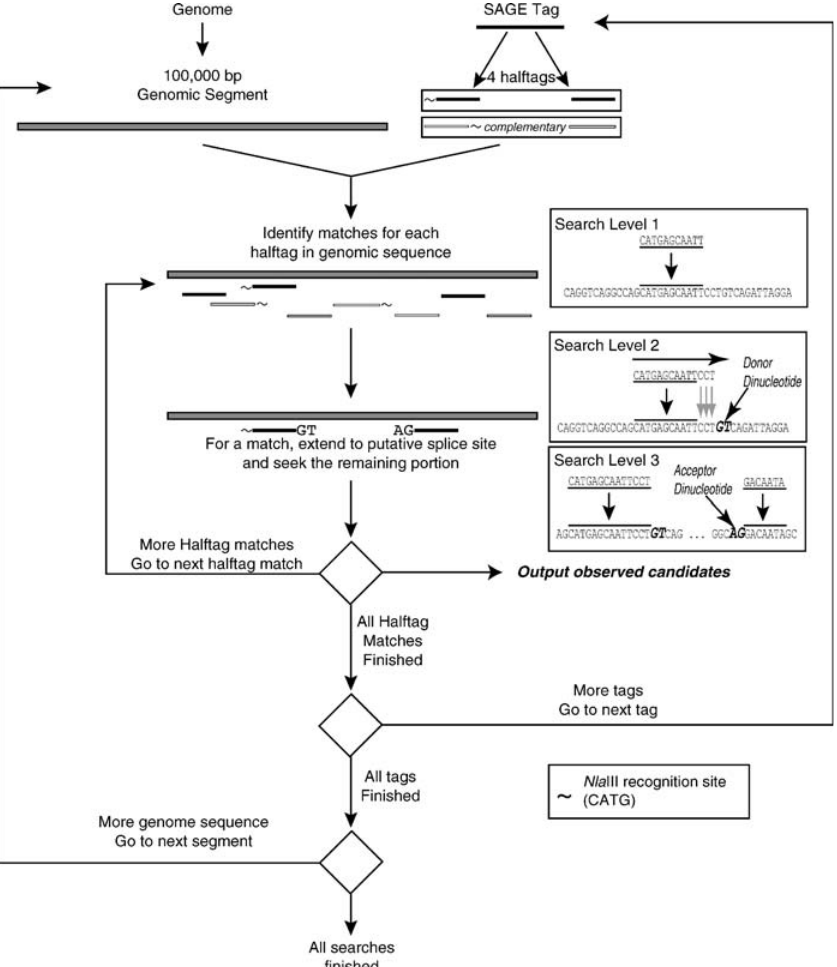
Figure 3. SAGE2Splice Algorithm Searches the Genome for Novel Splice Junctions By splitting each tag into two halftags and making complementary copies, the algorithm searches for candidate splice junctions against continuous segments of the genome in three progressive steps. After each level, if the matching criteria are fulfilled, the algorithm goes on to the next level. If criteria are not fulfilled, the algorithm analyzes the next tag. Once all tags have been analyzed, the next genomic segment is read, and the algorithm returns to the first level. DOI: